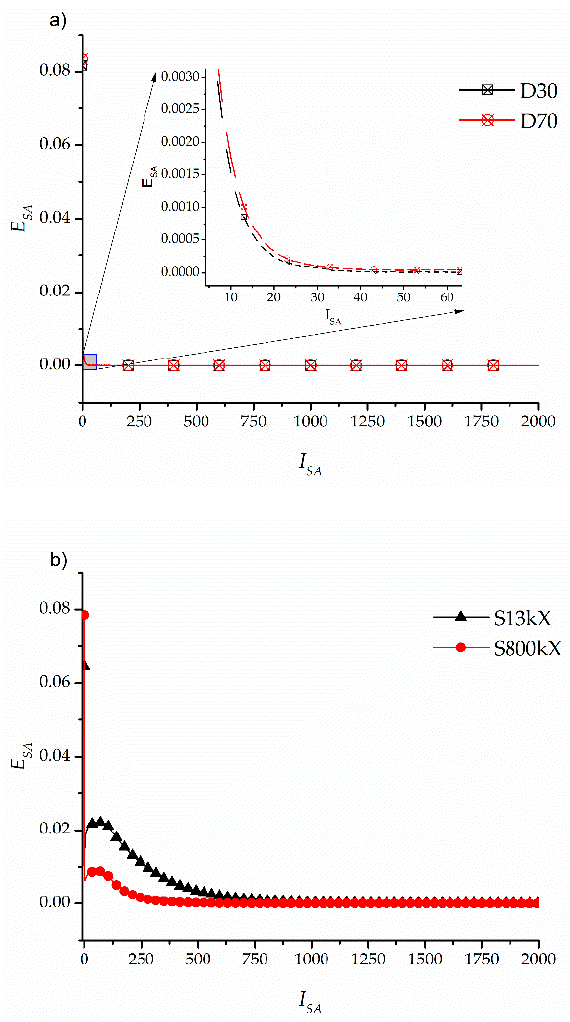
Figure 6. Average error of the simulated annealing (SA) process: ( a ) results for samples D30 and D70; ( b ) results for samples S13kX and S800X